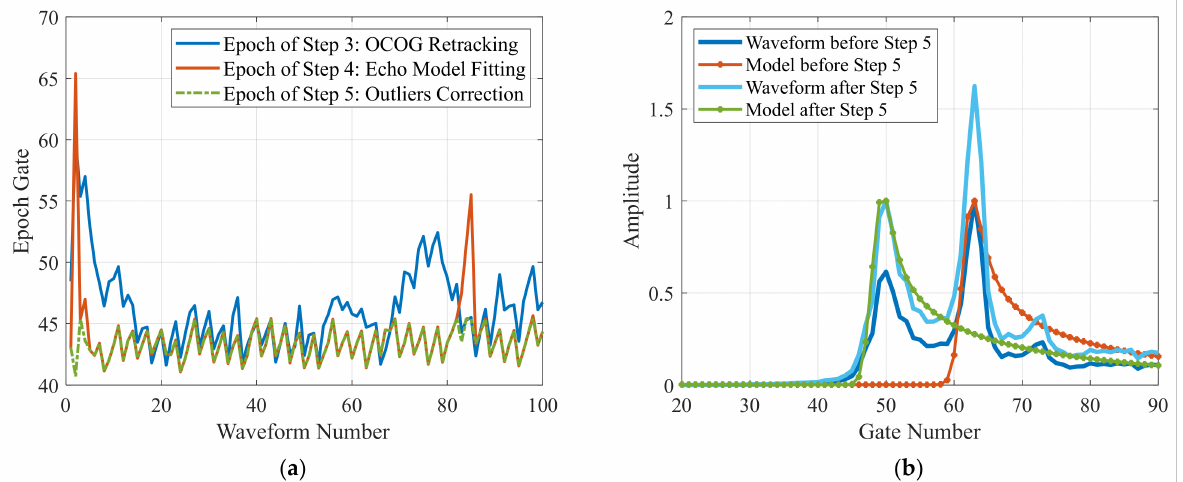
Figure 4. ( a ) The epoch sequences obtained by processing the coastal waveforms of experiment area 1 in April after steps 3 (blue curve), 4 (red curve), and 5 (green curve). ( b ) The coastal waveforms before and after step 5 (dark and light blue curves), and the corresponding fitting models (red and green